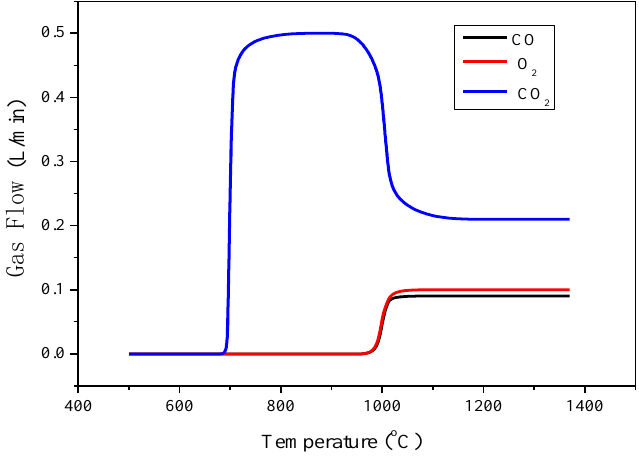
Figure 2. Temperature and atmosphere profile during the heating process.